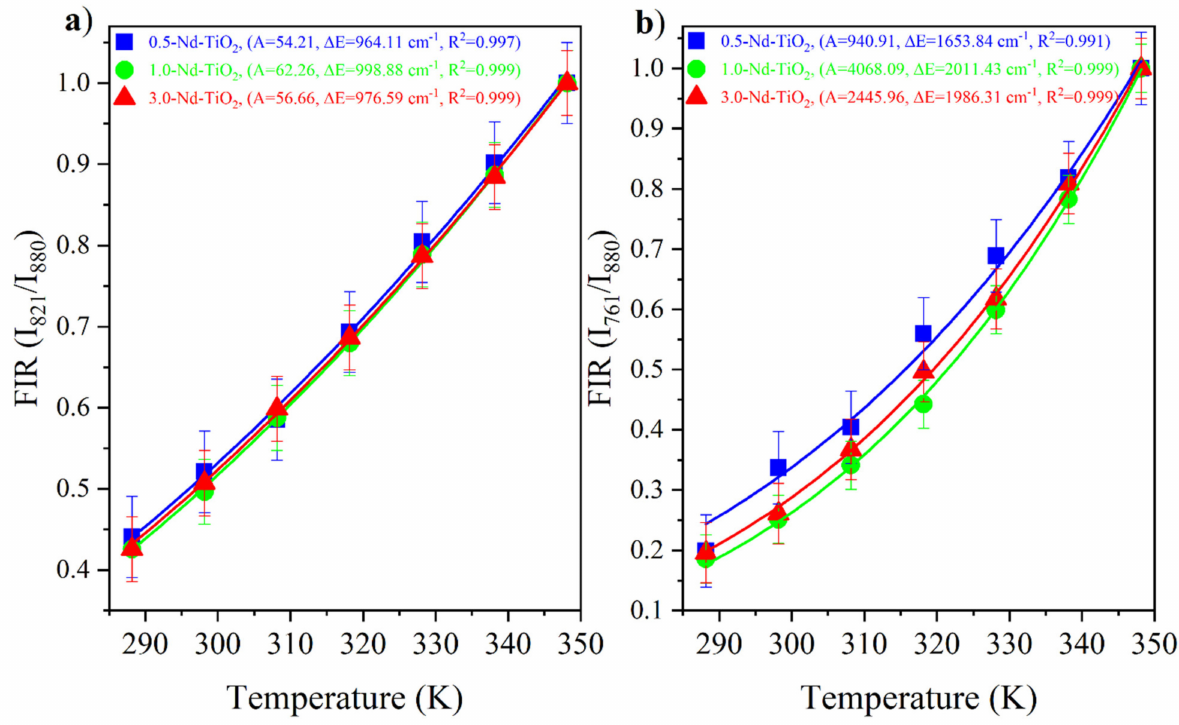
= 4 F 5/2 → 4 I 9/2 ratio ( a ) and I 880 4 F 3/2 → 4 I 9/2